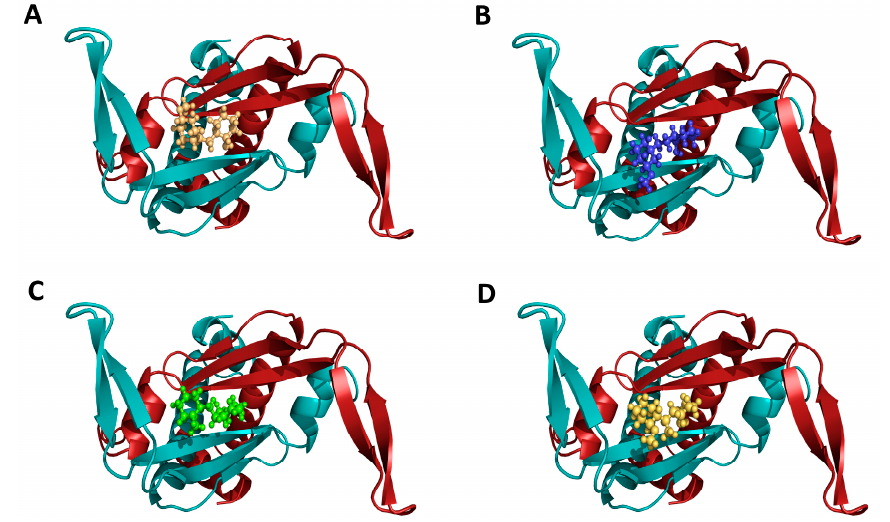
Figure 2. Top view of the docked poses of the diarylethenes 1 ( A ), 2 ( B ), 3 ( C ), 4 ( D ) with the DNA binding saddle of Mycobacterium tuberculosis HU protein.